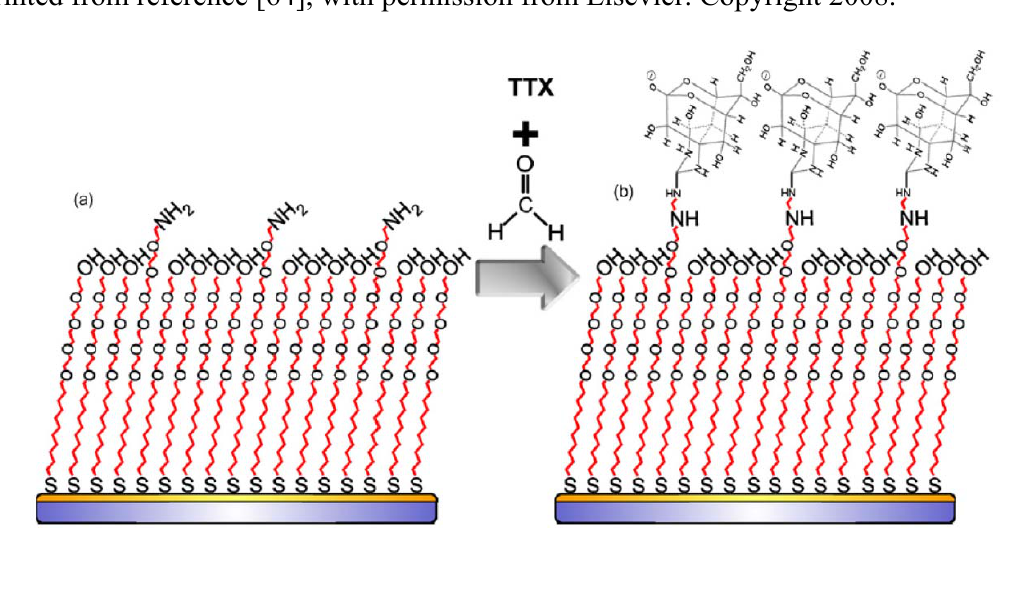
Figure 7. Immobilization of tetrodotoxin onto a mixed thiol SAM on an SPR gold surface. Reprinted from reference [64], with permission from Elsevier. Copyright